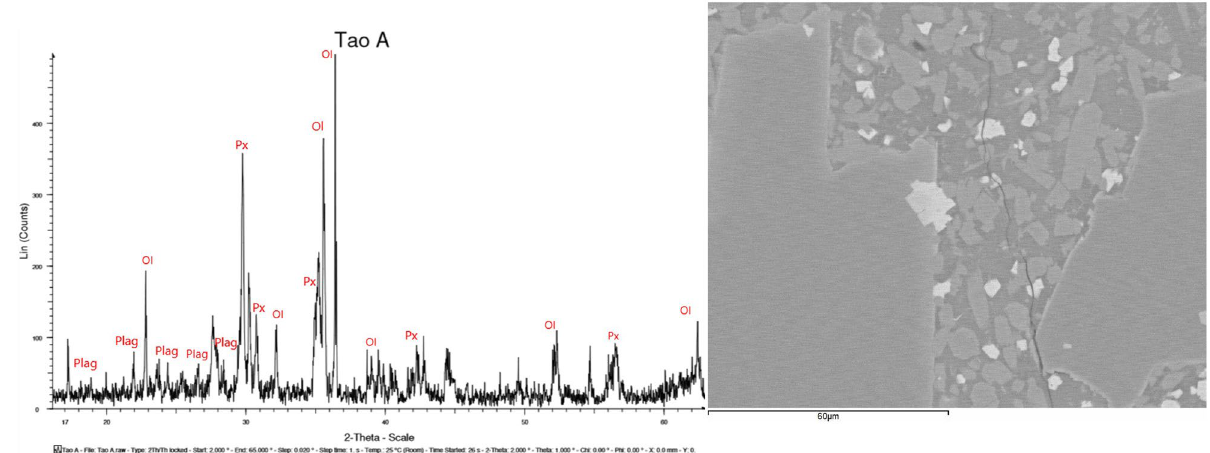
Figure 7. XRD data from LZS-1 and a detailed image of the SEM–EDX where the main mineral phases are represented.